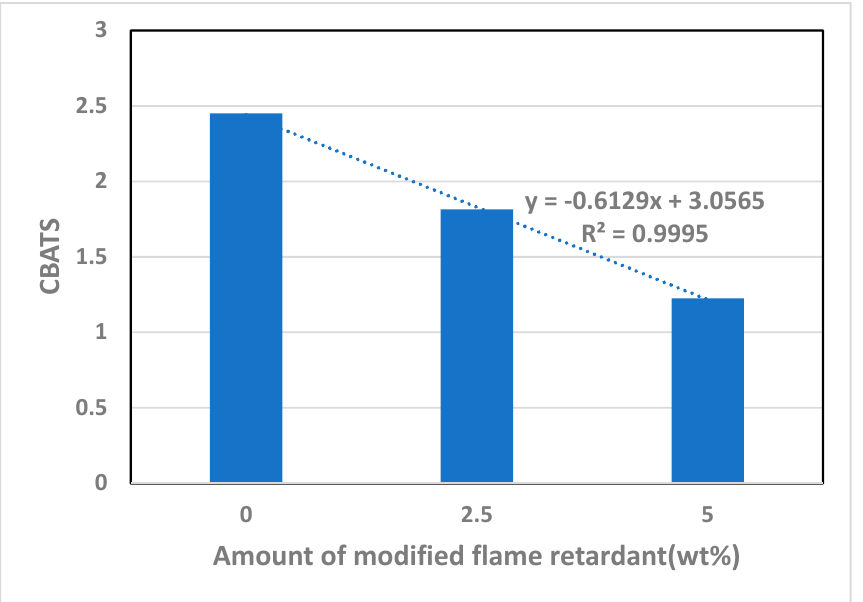
Figure 10. Relationship with CBATS as function of the increase in the amount of modified flame retardant